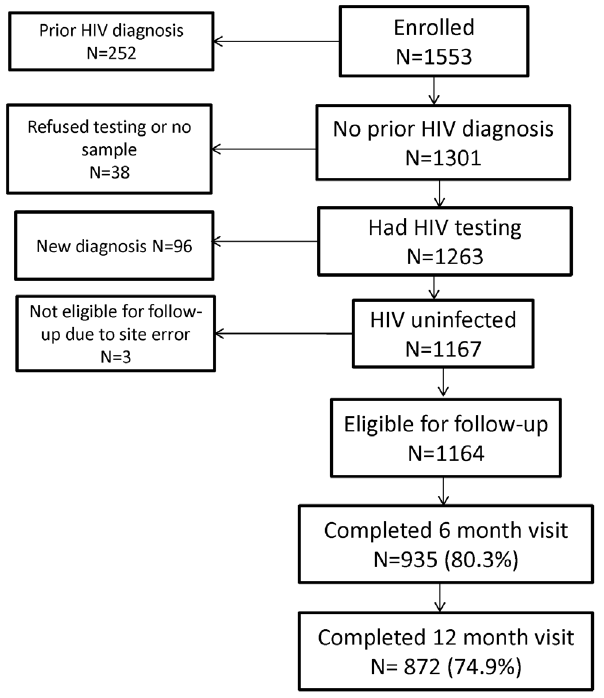
Figure 1. Flow diagram of study sample, HPTN 061*. *Men were categorized as previously diagnosed (prior HIV diagnosis) based on self- report or retrospective detection of antiretroviral drugs in samples from the enrollment visit (see Methods). The newly diagnosed group included three men who had acute HIV infection at enrollment.